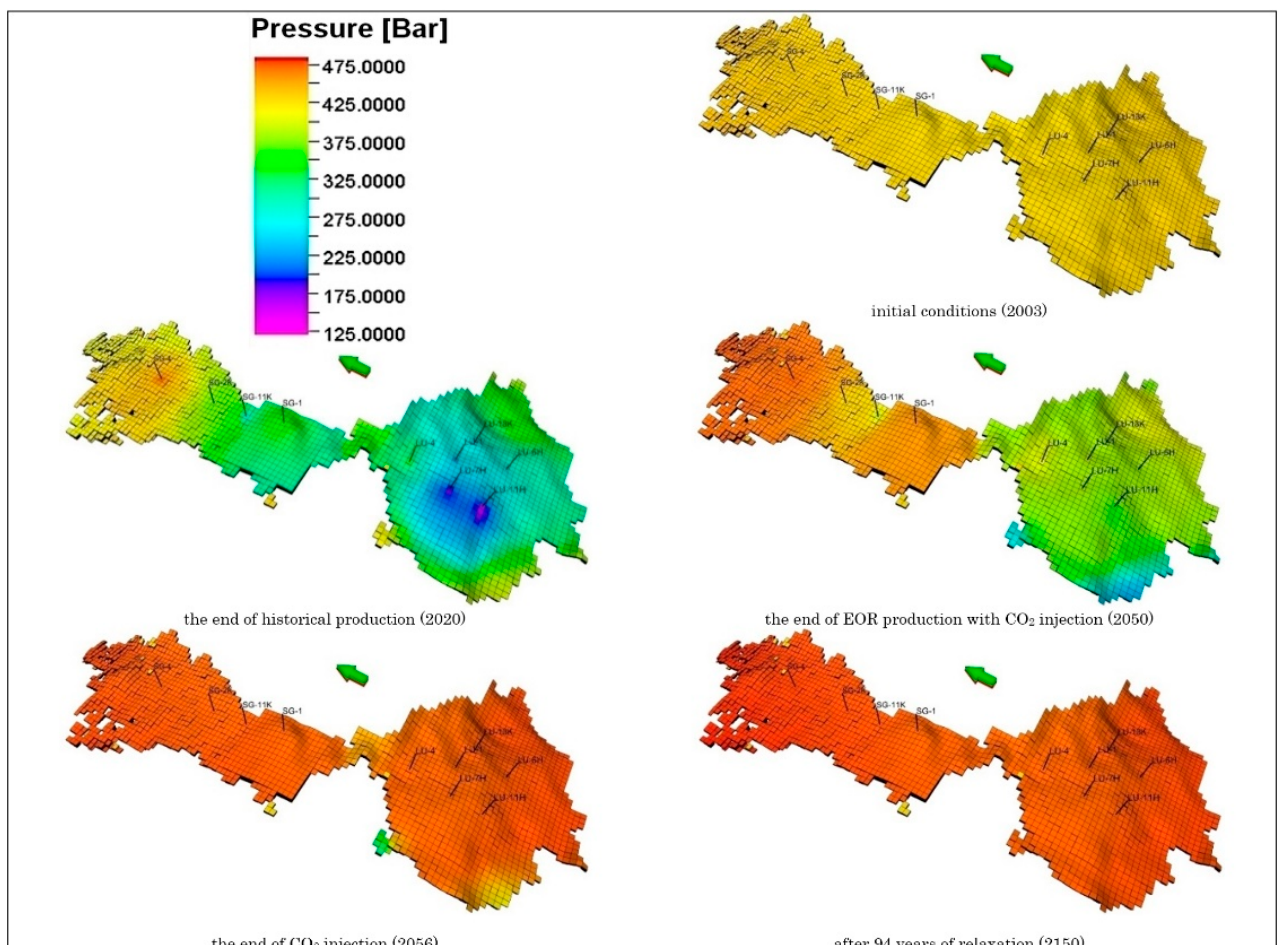
Figure 20. Pressure distributions at the reservoir top at various stages of the project.